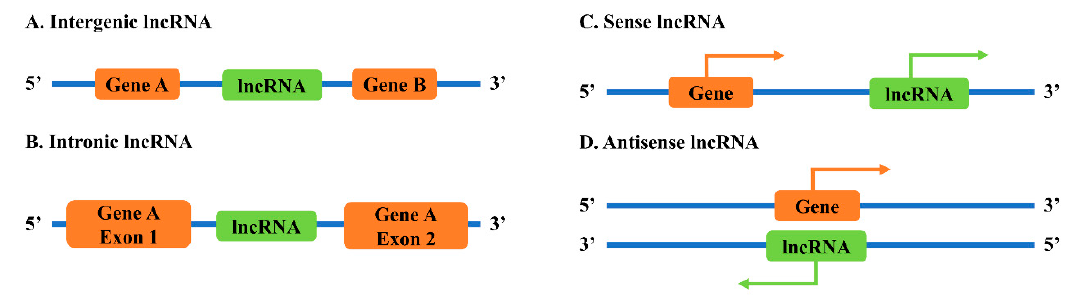
Figure1. ClassificationoflncRNAsbasedongenomiclocationswith: ( A )intergeniclncRNA;( B )intronic Figure 1. Classification of lncRNAs based on genomic locations with: ( A ) intergenic lncRNA; ( B ) lncRNA; ( C ) sense lncRNA; and ( D ) antisense intronic lncRNA; ( C ) sense lncRNA; and ( D ) antisense lncRNA.